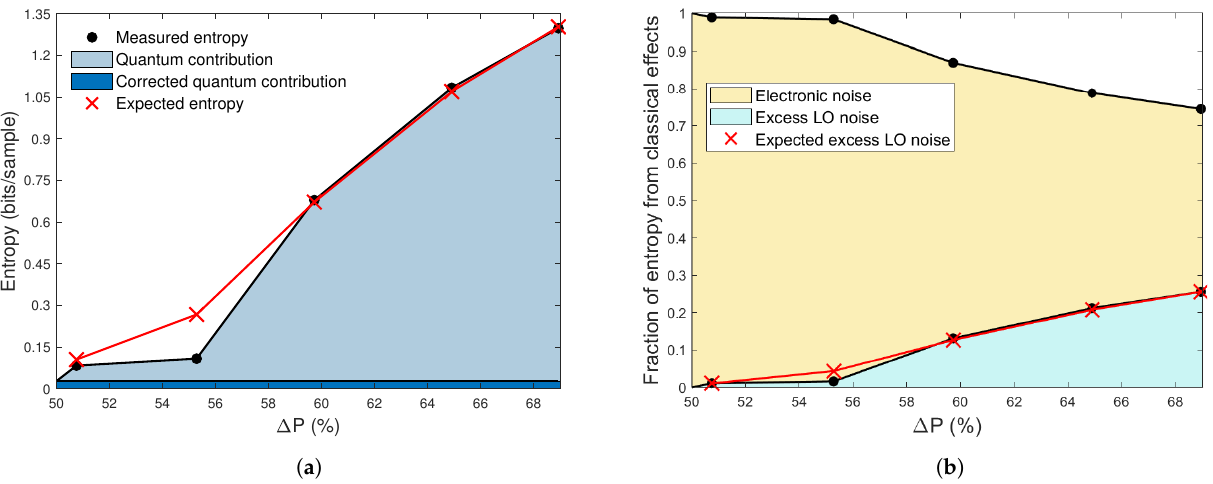
Figure 5. ( a ) Quantum entropy contribution in function of the detection asymmetry. Dark blue shaded area shows the corrected H quant , when H unbal is considered. ( b ) Fraction of entropy from classical effects attributed to the electronic and excess LO noise. Red lines present the entropy values for the theoretically expected